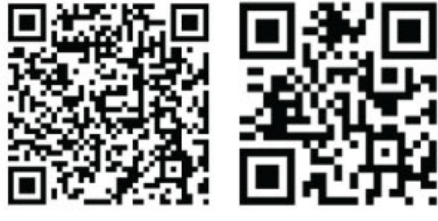
The QR code on the left points to the original web page URL. The less complex code on the right illustrates the benefit of using a shortened URL to point to that web